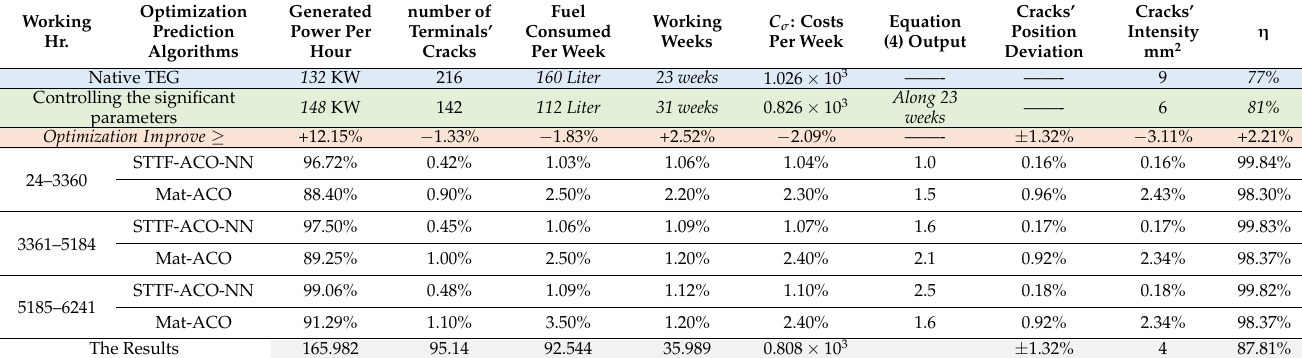
Table 6. The average deviation from the actual observation values along tm: 6241 working